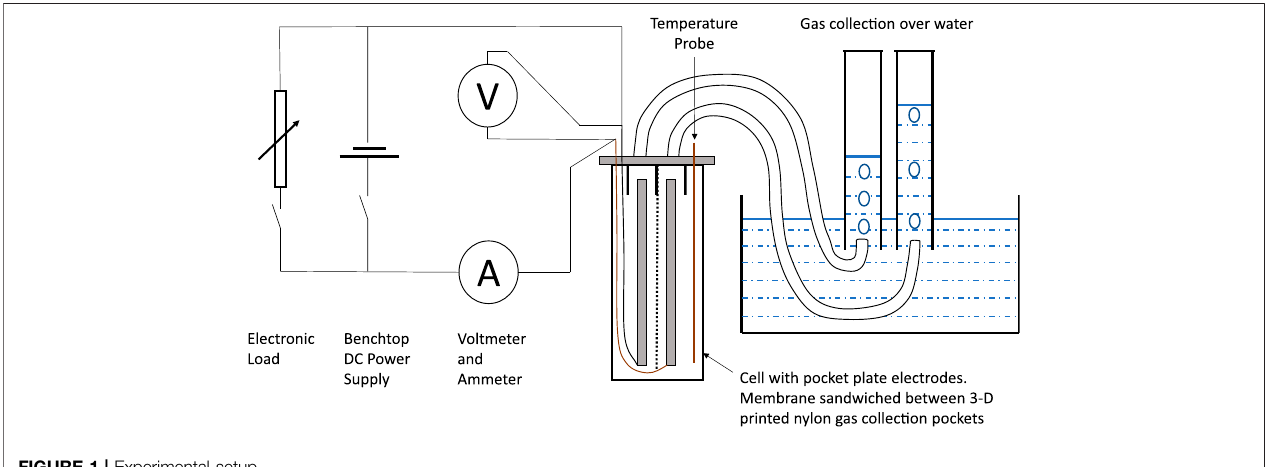
FIGURE 1 | Experimental setup.